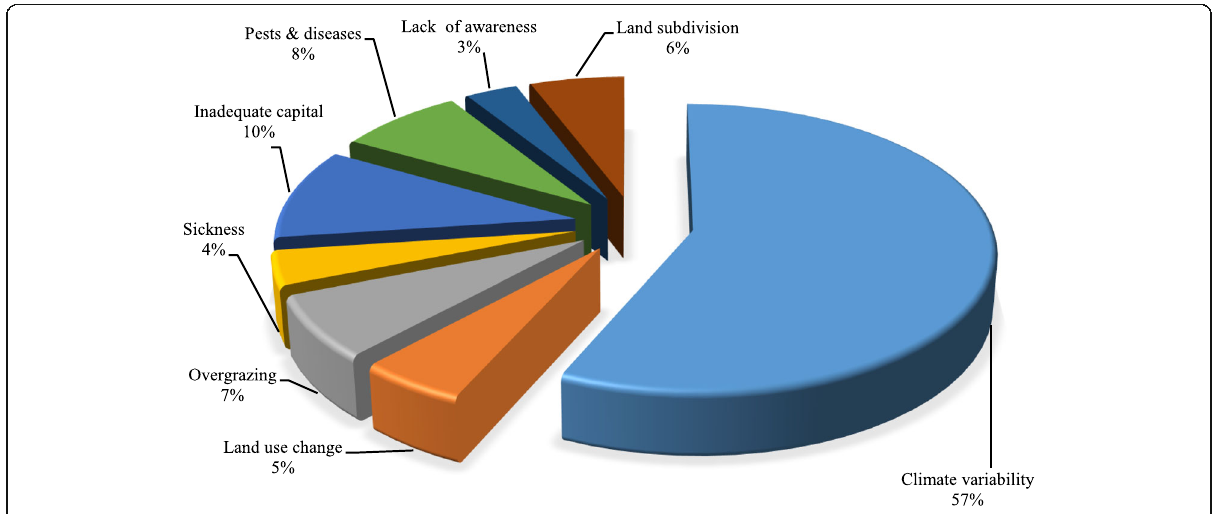
Fig. 4 Key factors attributed to depressed crop and livestock output in the area (Source: Field Data,